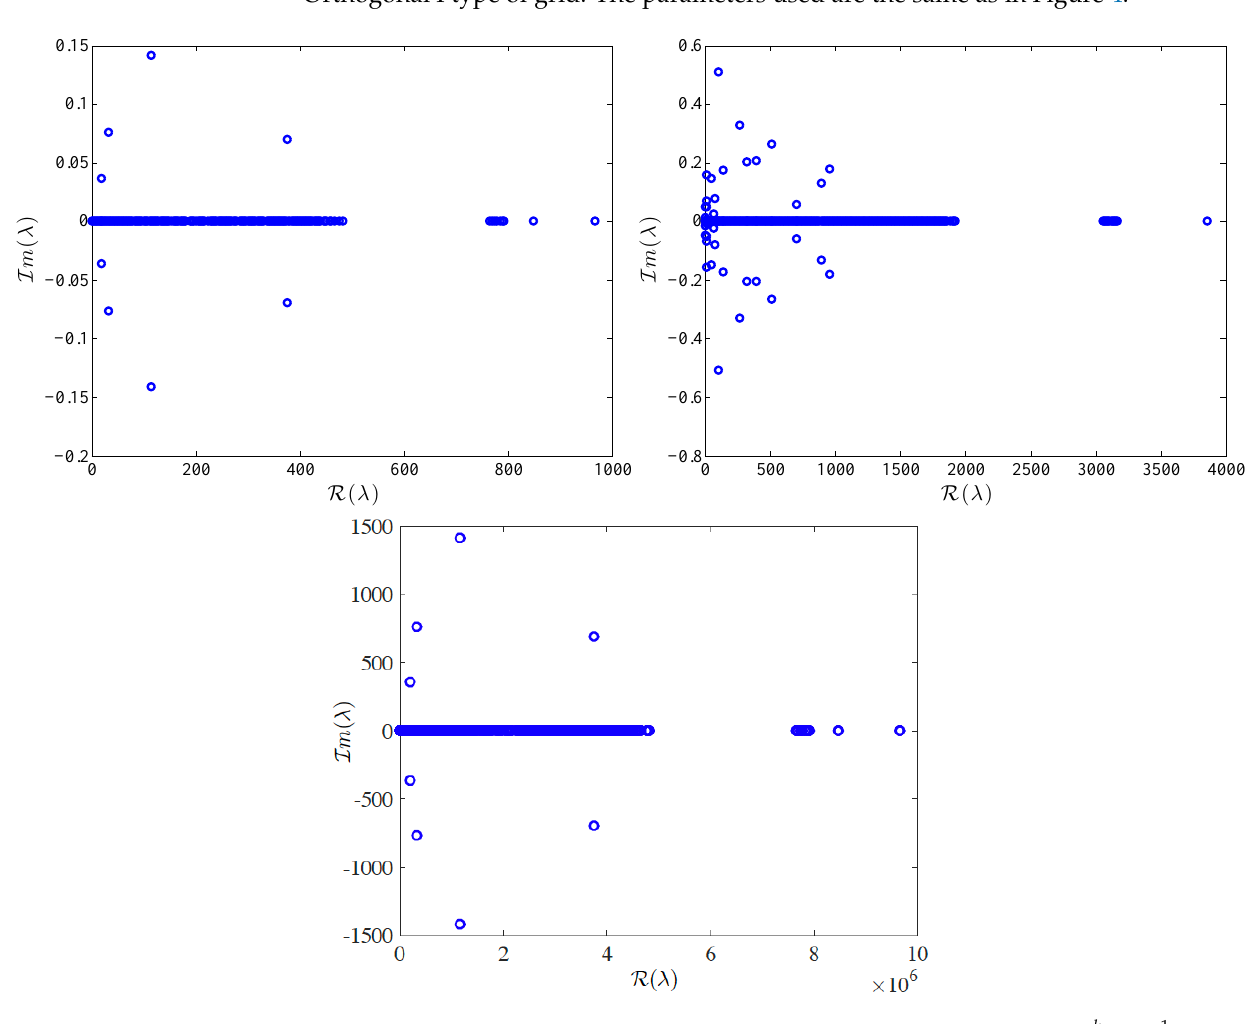
= 1 ( top left ), 0.058 h N